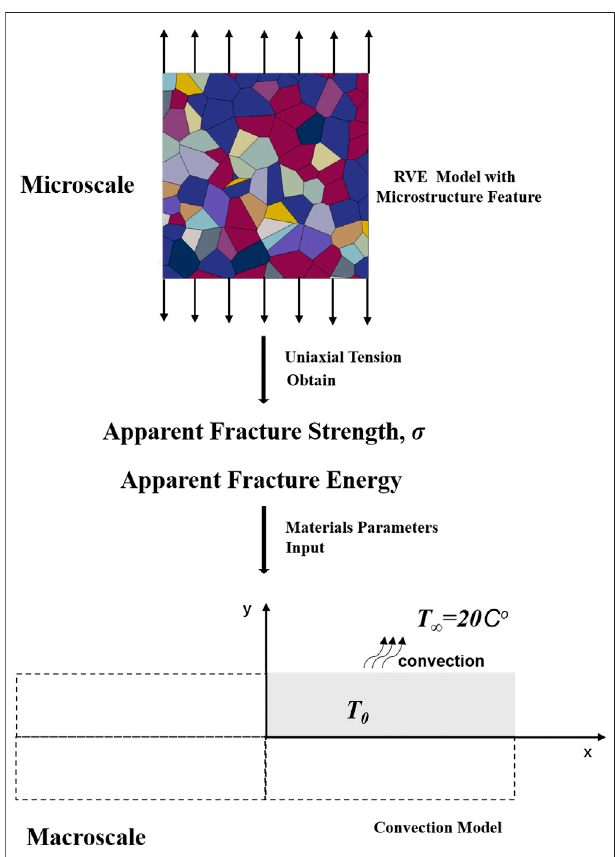
FIGURE 1 | Dual-scale model of thermal shock